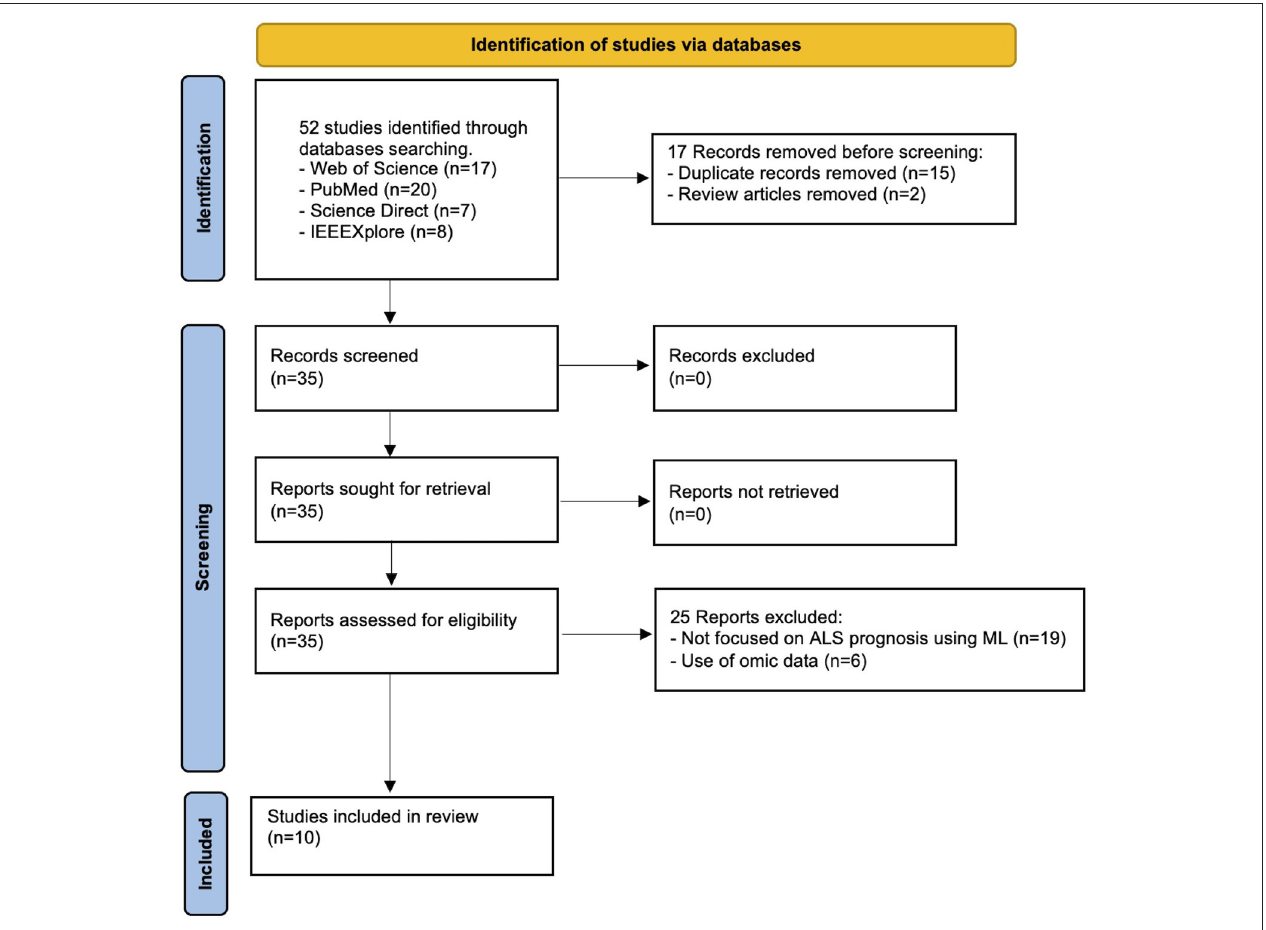
FIGURE 1 | PRISMA flow chart of this